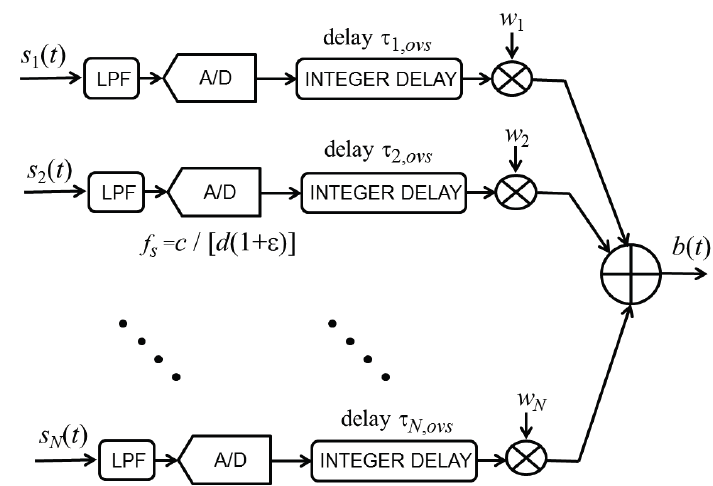
Figure 11. Schematic of oversteered end-fire beamformer for a suitable sampling frequency f s